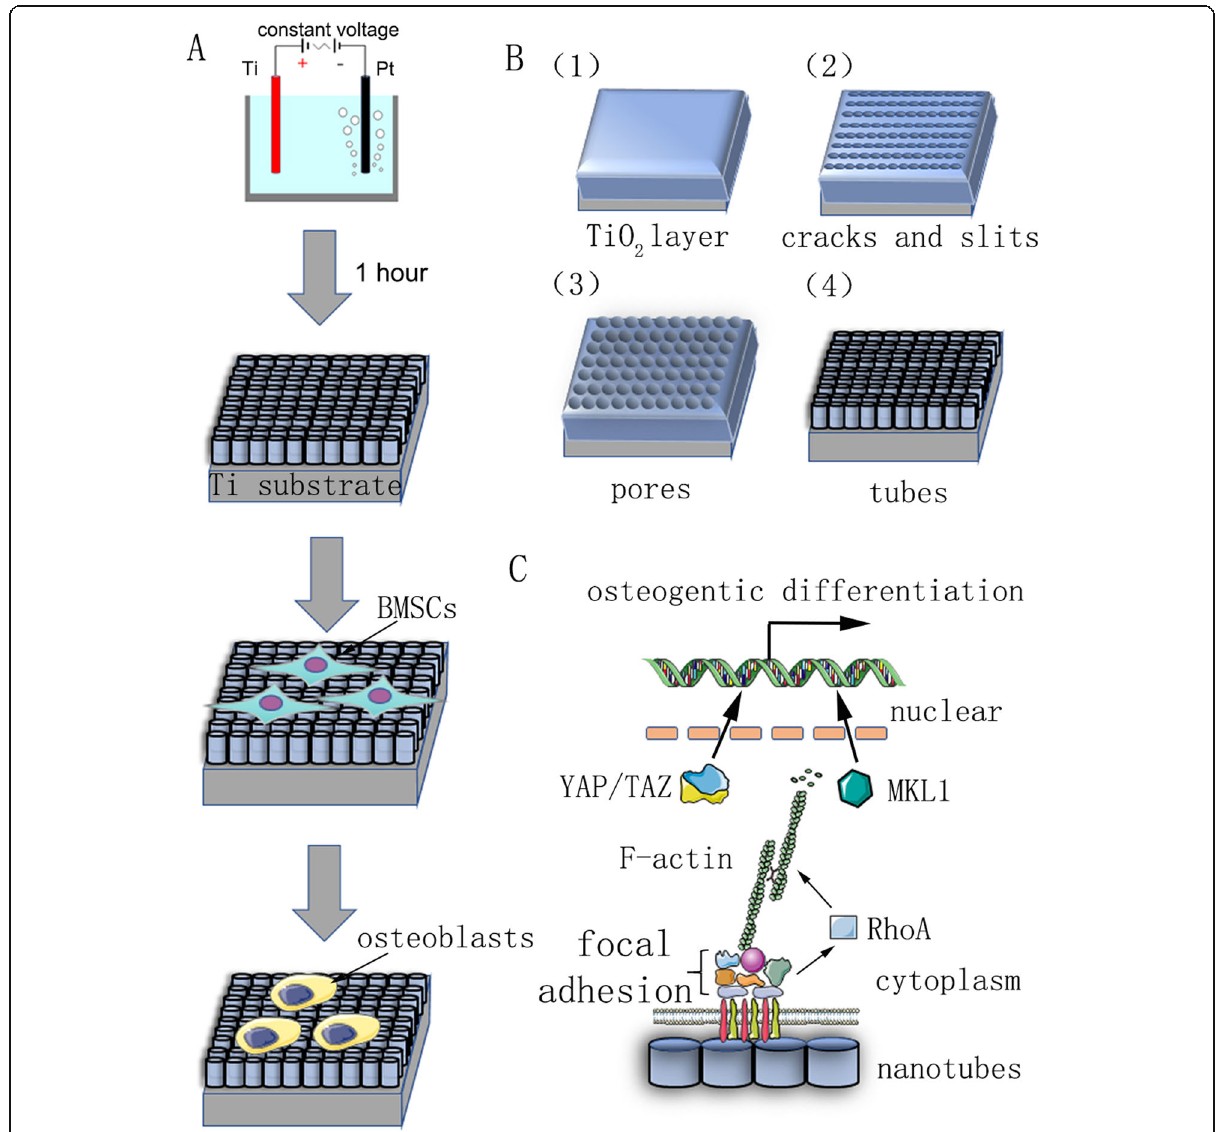
Fig. 1 A summary chart of our study. a Flow chart showing anodic oxidation and induction of cell differentiation. b The pretreated titanium substrate was fixed as the anode in an electrolyte aqueous solution with 0.15 M NH 4 F and 90% glycol at constant voltage for 1 h. Self-assembled nanotubes were predicted to be formed uniformly. Its reaction mechanism is described in materials and methods. c Schematic diagram of